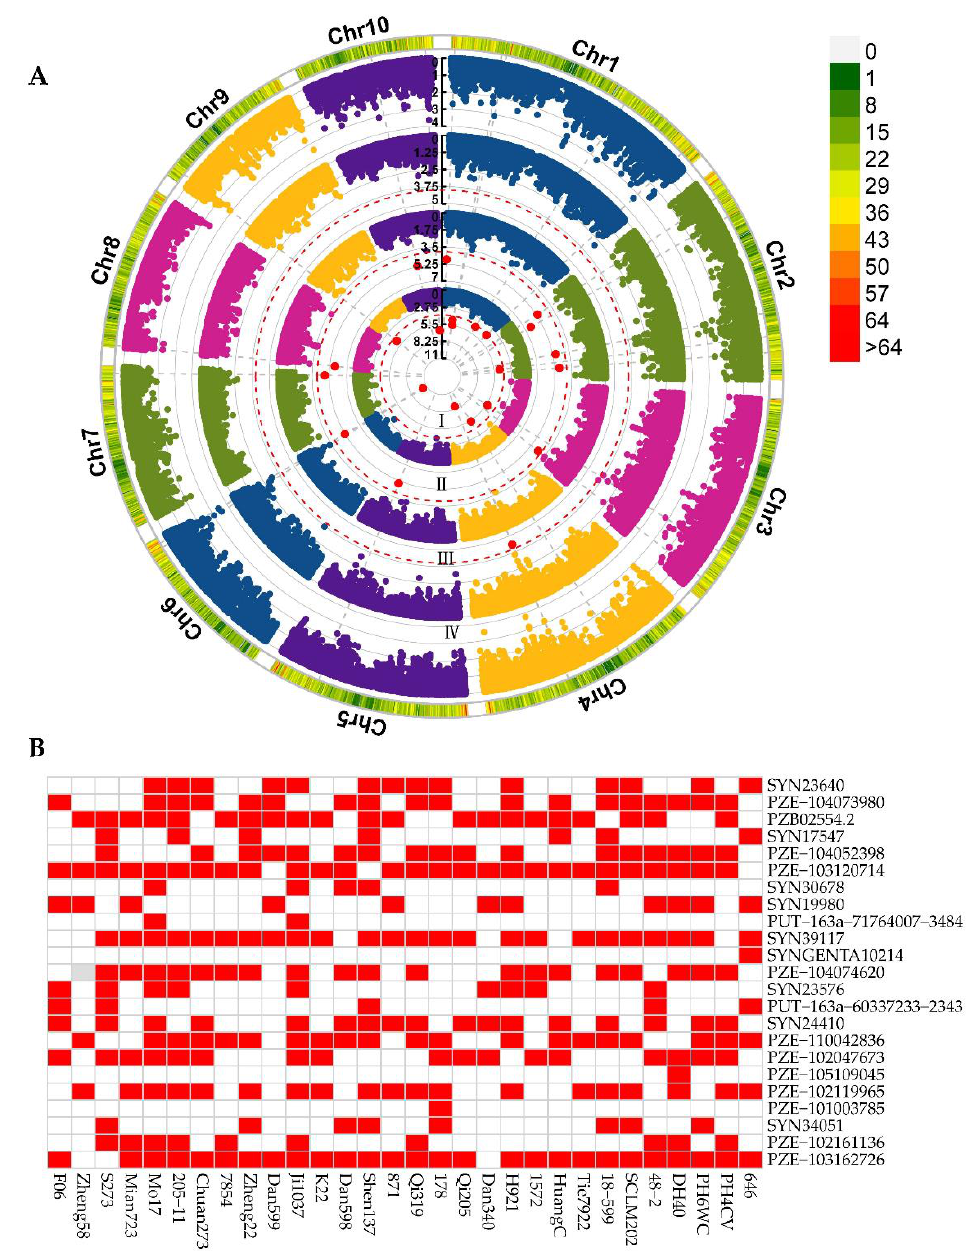
Figure 3. GWAS results and superior allele distributions. ( A ) Manhattan plots of genome-wide association study for ESL by using the FarmCPU model. (I) CZ, Chongzhou; (II) YA, Ya’an; (III) XSBN, Xishuangbanna; (IV) BLUP, BLUP, best linear unbiased prediction. Chr–Chr10 represent chromosomes 1–10; ( B ) Heatmap of superior allele distributions in the 30 elite lines. Red and white squares represent the superior and inferior alleles, respectively.